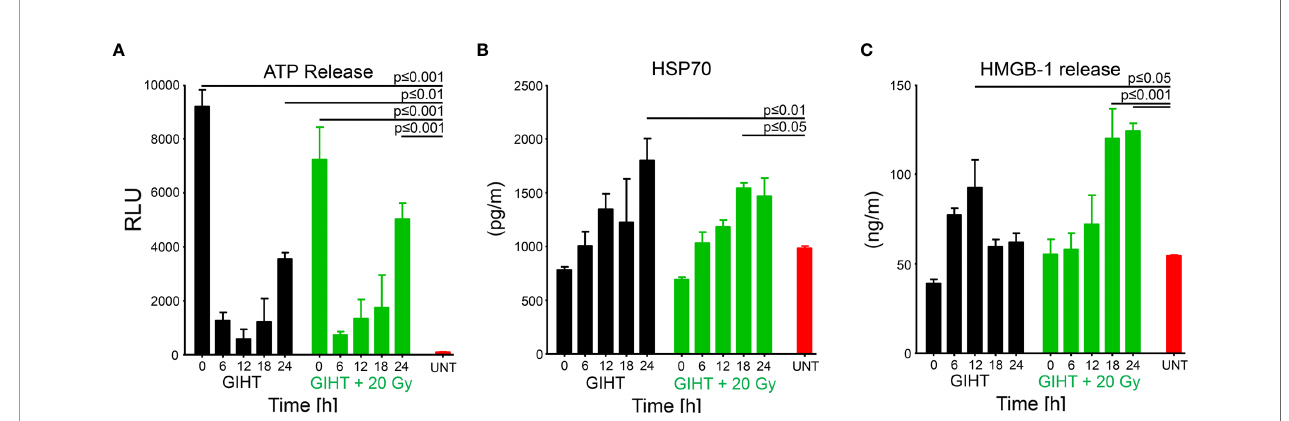
FIGURE 4 | Organic adjuvants released from GIHT treated B16F10 melanoma cells. (A) Time kinetic of the levels of ATP, (B) HSP70, and (C) HMGB-1 detected in supernatants after the application of the treatment. Supernatants from untreated cells (UNT) represent basal concentrations of DAMPs. The two-way analyses of variance with Bonferonni posttest was employed. Values of p < 0.05 were considered as signi fi cant. Means with the standard error of the mean (SEM) are shown. GIHT, graphene induced hyperthermia; UNT, untreated; ATP, adenosine triphosphate; HSP70, heat shock protein 70; HMGB1, high mobility group box 1